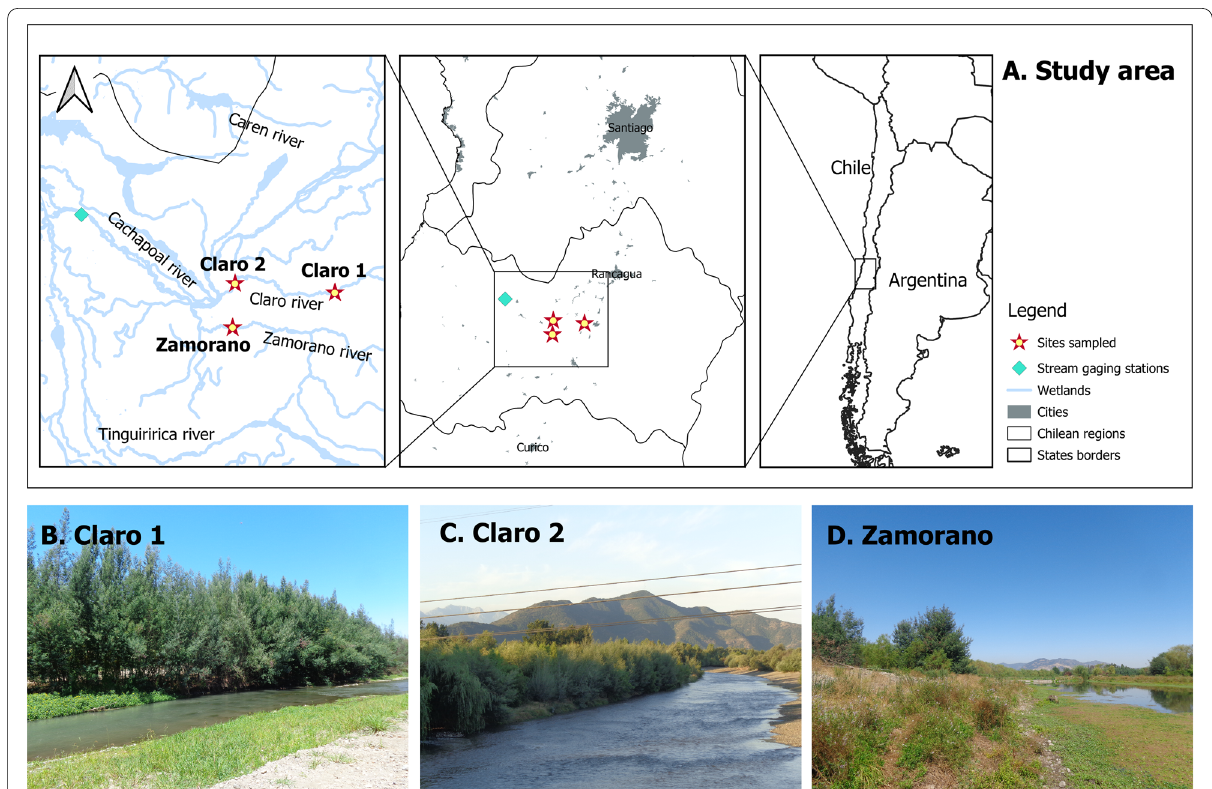
Fig. 1 Location of the three study sites within the Cachapoal River basin in Central Chile, also showing the stream gaging stations with water temperature data, as well as the main cities and towns ( A ). Each sampling site is pictured below ( B , C , D